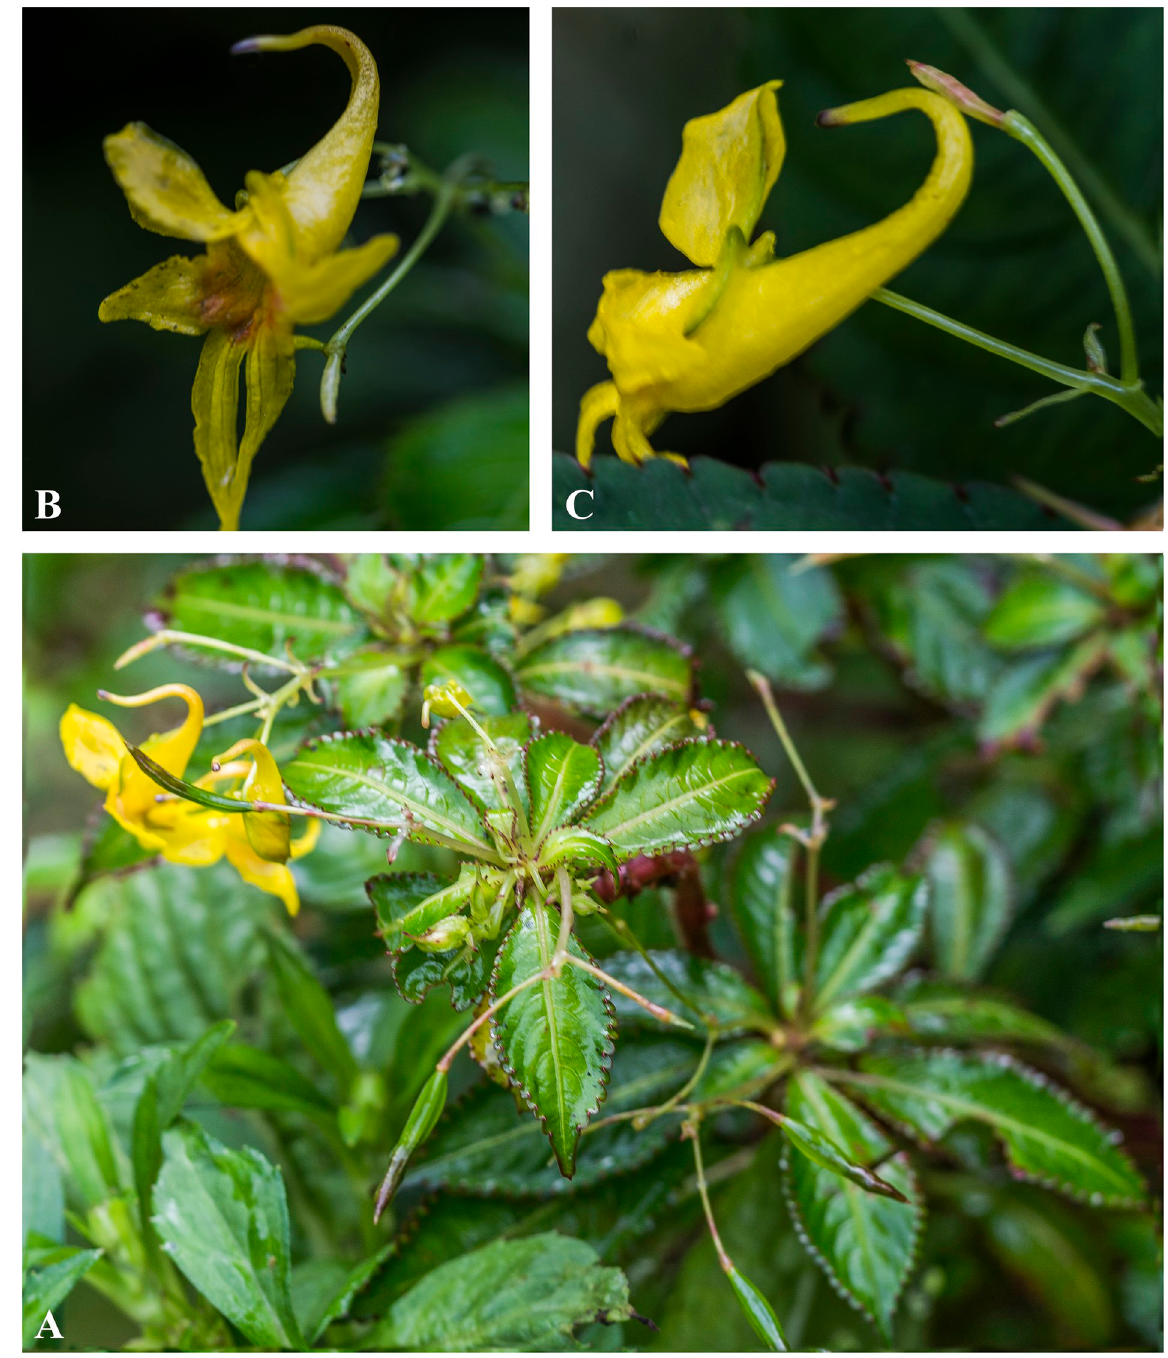
Fig 28. Impatiens stenantha A. Flowering plant; B. Flower (Front view); C. Flower (side view). Photographs by Bhakta Bahadur Raskoti.